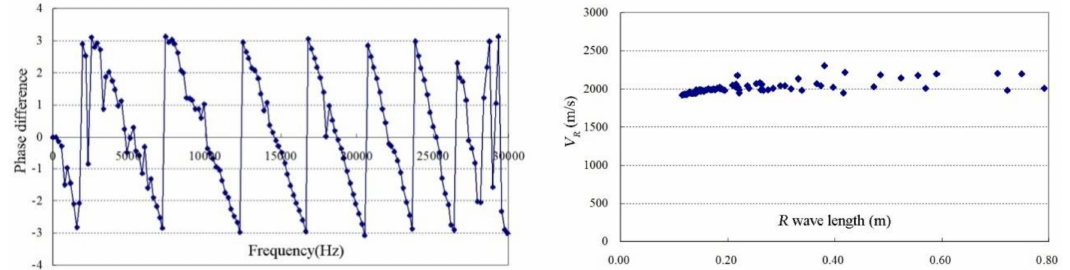
Figure 6. Phase spectrum and dispersion curve of the uniform model.